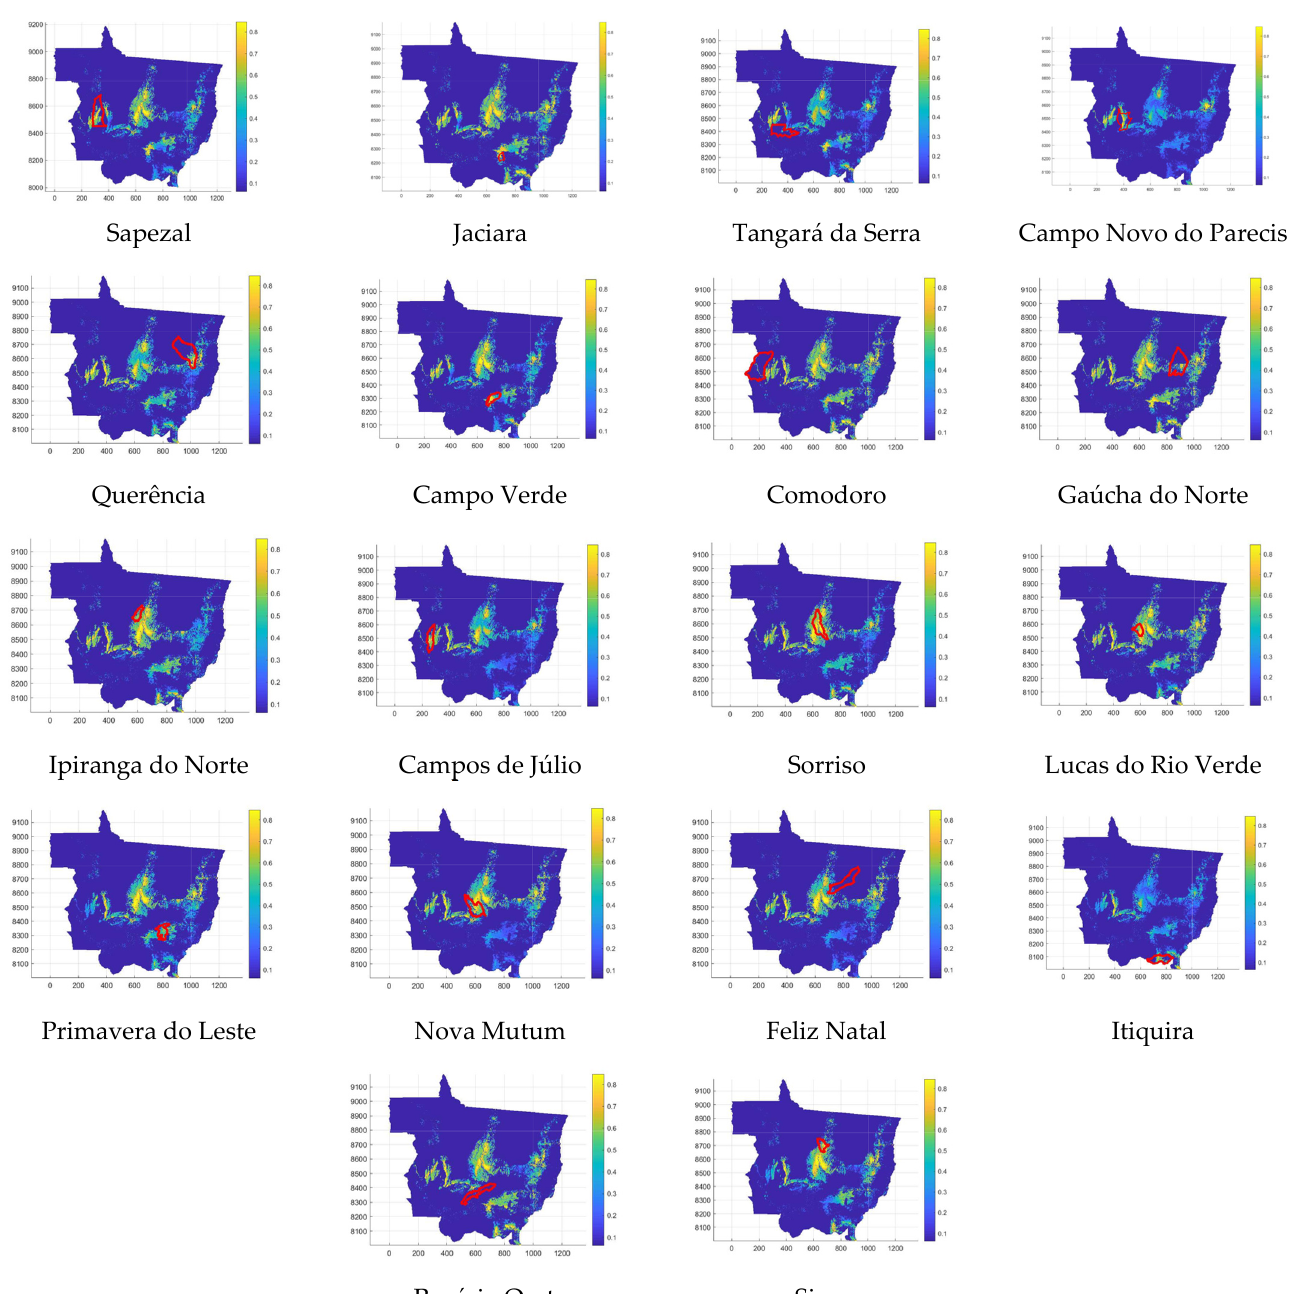
Figure 7. Fuzzy occurrence for localities (outlines in red) where occurrences were recorded in 2018/2019